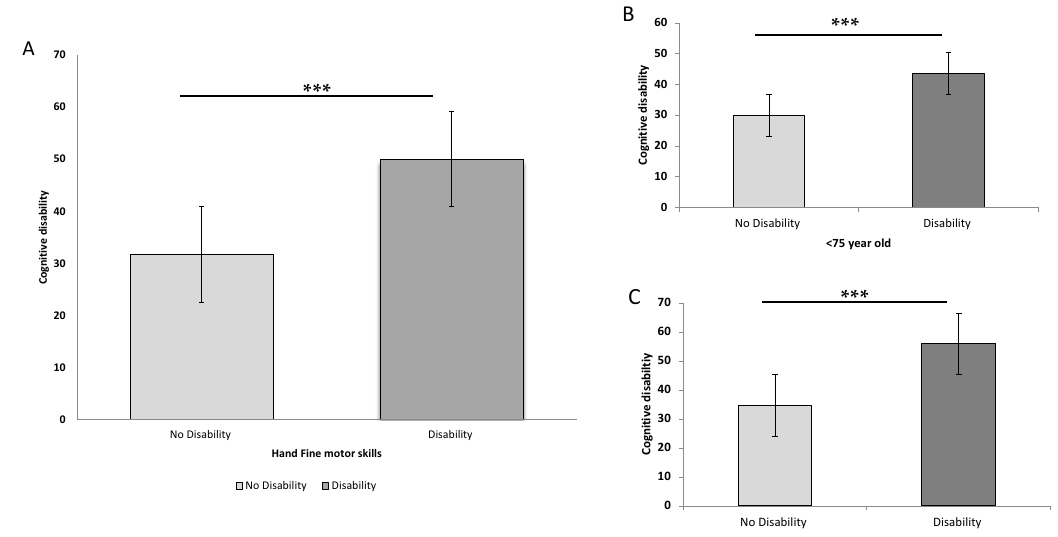
Figure 2. Comparison of cognitive disability between moderate-to-advanced Parkinson’s disease (PD) patients without dementia but with hand fine motor skill disability and those without dementia or hand fine motor skill disability. ( A ) Cognitive disability was significantly greater in all PD patients with fine motor skill disability than in those without disability. The results were identical for patients with PD aged ( B ) <75 or ( C ) ≥75 years. All data are presented as mean ± SD (*** p < 0.001).